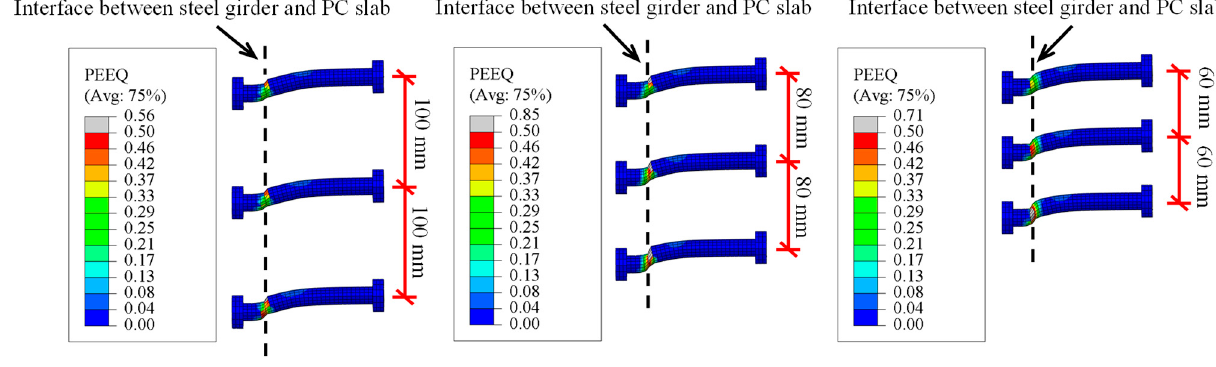
Figure 9. The deformation of an individual bolt in the multi-bolt shear connectors.